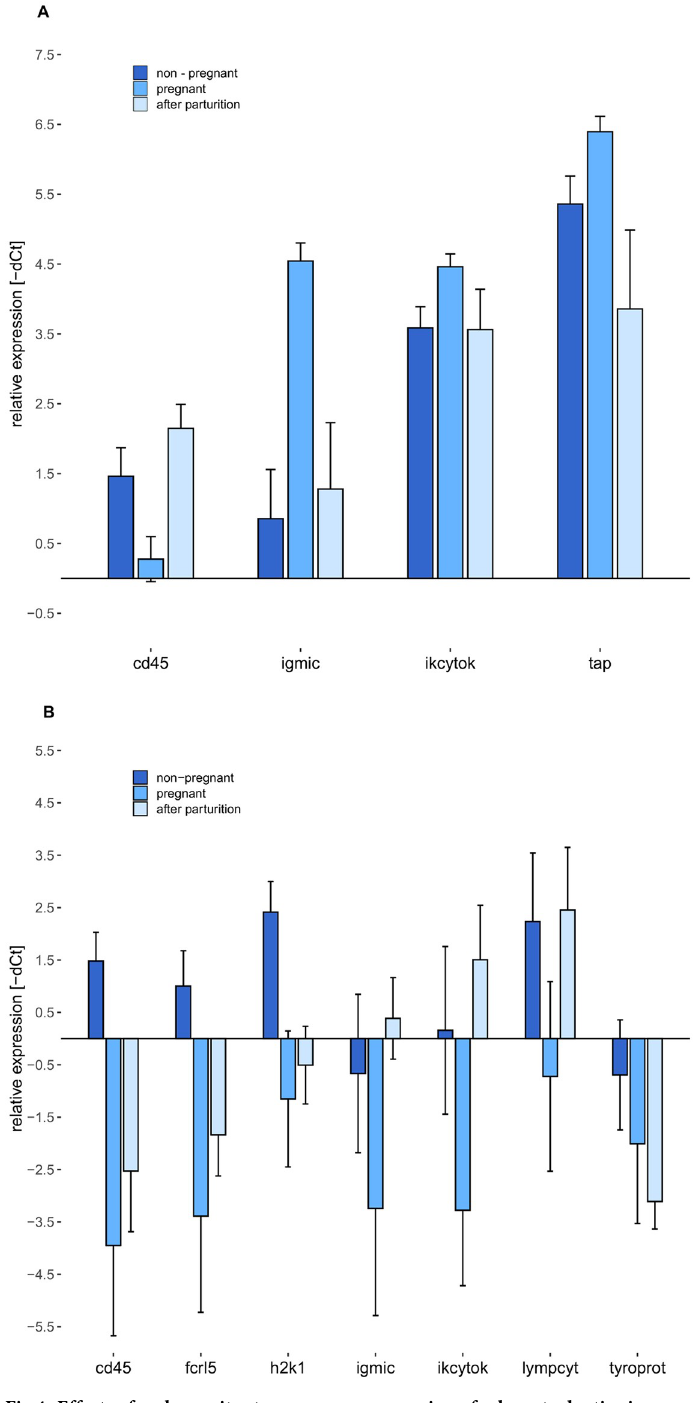
Fig 4. Effects of male gravity stages on gene expression of relevant adaptive immune system genes. Both graphs show the group mean and standard error of the relative gene expression (-dCt) of adaptive immune system genes with a higher contribution to the respective PCA than expected by chance. Non-pregnant males are shown in dark blue, pregnant males in blue and males after parturition in light blue. ( A) Effects of male gravity stages on gene expression in S . rostellatus . ( B) Effects of male gravity stages on gene expression in S . typhle .